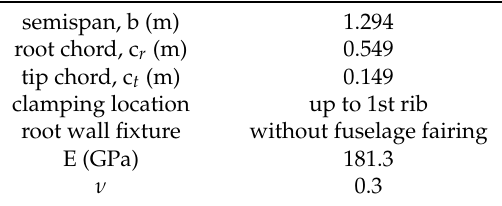
Table 5. high Reynolds number aerostructural dynamics (HiReNASD) geometry and material properties.